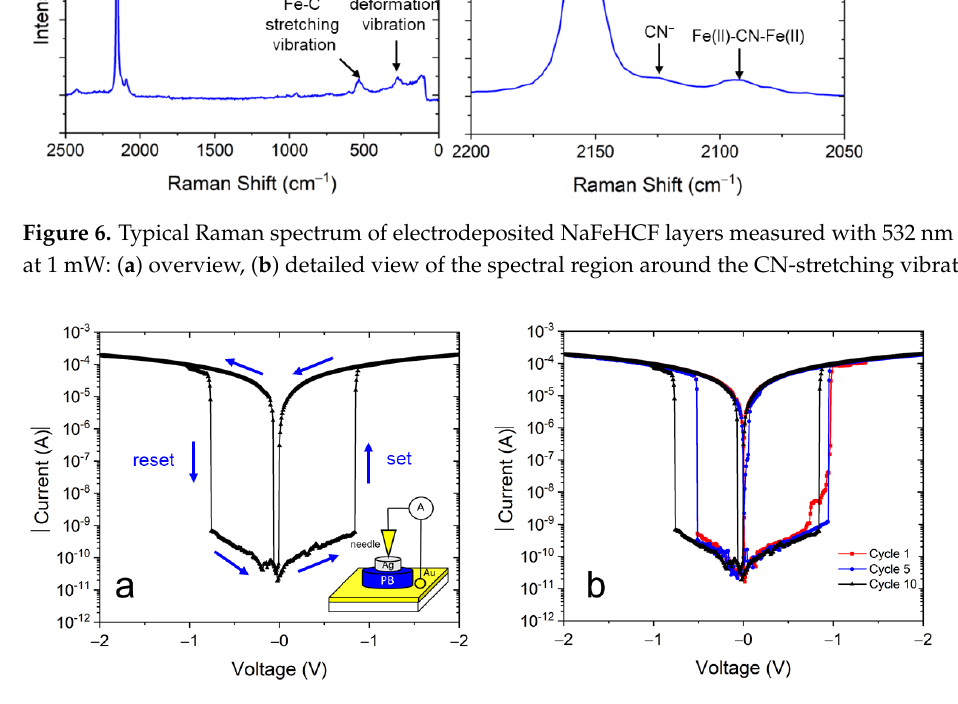
Figure 7. ( a ) Typical I–V curve of the Au/NaFeHCF/Ag layer sequence. The inset shows the used measurement geometry. ( b ) I–V curves of Au/NaFeHCF/Ag layers at different cycle numbers. The bias voltage range was +2.0 V to − 2.0 V.